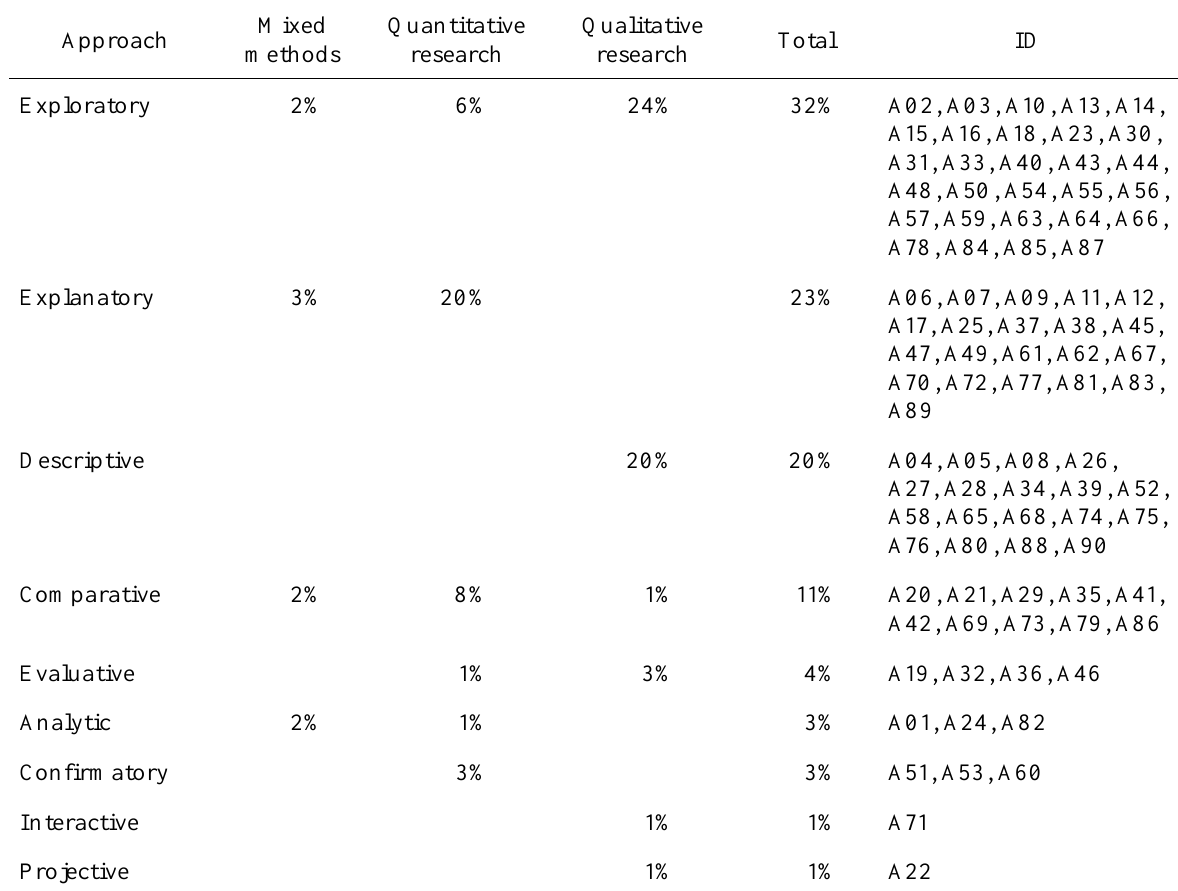
Table 8 Classification by Approach and Research